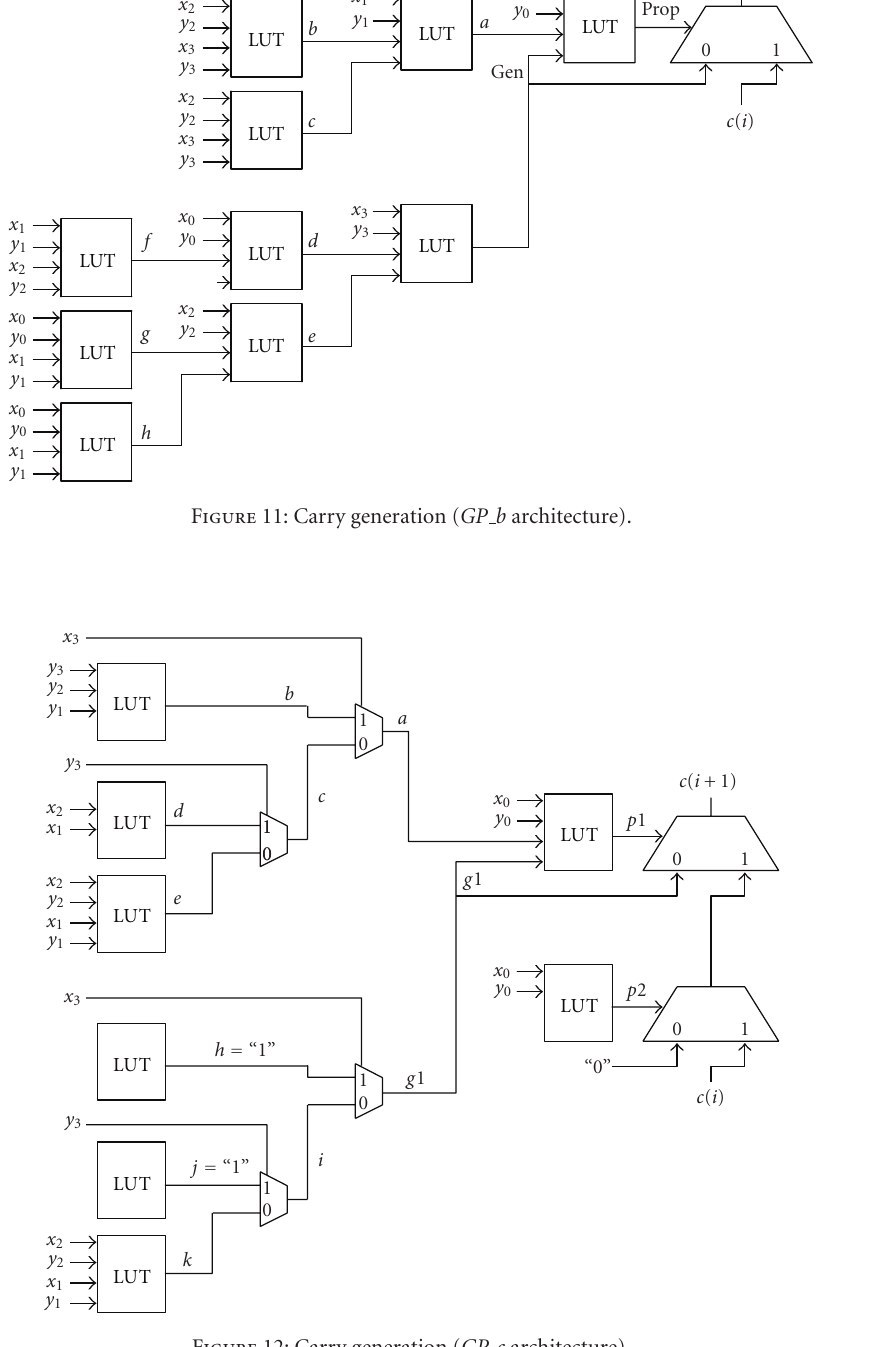
Figure 12: Carry generation ( GP c